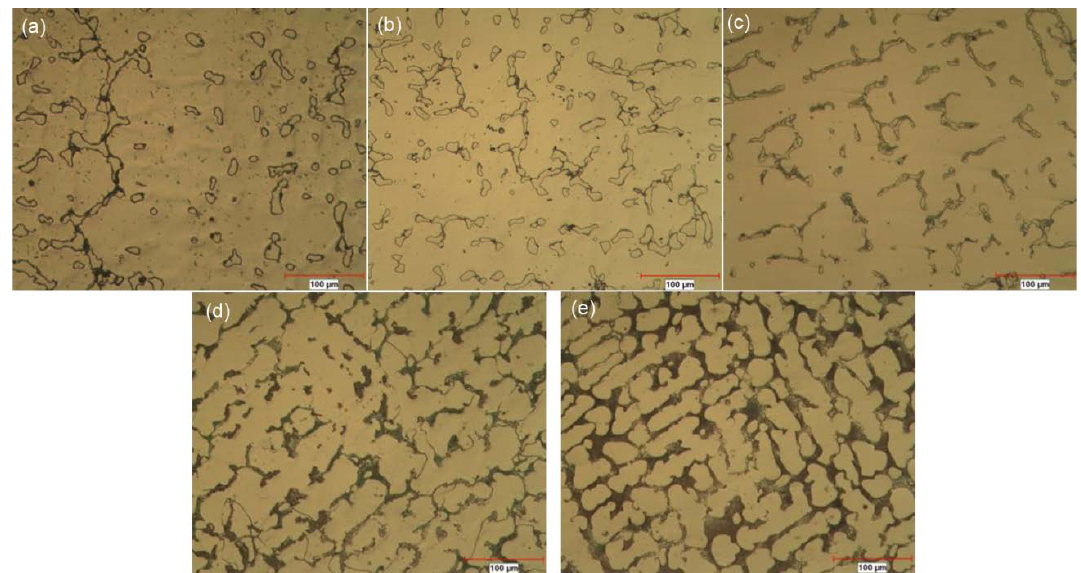
Figure 1. Microstructures of the as cast alloys with ( a ) 0B, ( b ) 0.06B, ( c ) 0.25B, ( d ) 0.5B, and ( e ) 1B. The images were taken at 200×.